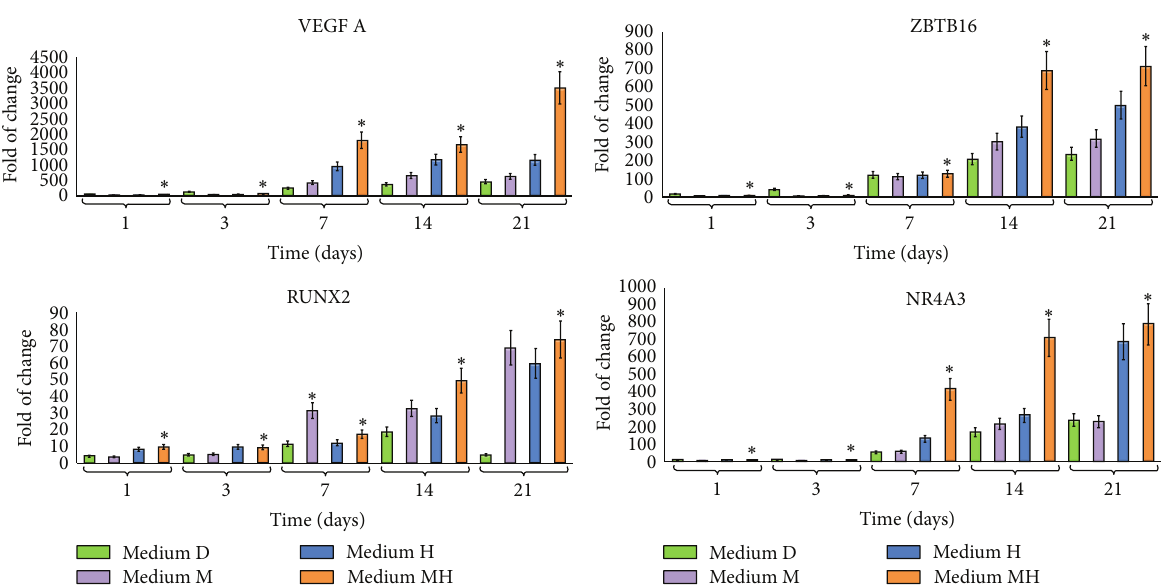
Figure 1: Effect of melatonin and HA + BU + RA exposure on the expression of genes orchestrating hDPSCs commitment toward an osteogenic lineage. Cells were exposed for 1, 3, 7, 14, or 21 days in the presence of one of the 4 conditioned media described under Materials and Methods and based on 100 nM dexamethasone with 200 𝜇 M L-Ascorbic acid 2-phosphate (medium D), 0,01M melatonin (medium M), or a mixture of HA 2 mg/mL + BU 5 mM + RA 1 𝜇 M (medium H) or on a combination of melatonin together with HA + BU + RA (medium MH) or kept at the undifferentiated state by growing on medium C. The amounts of vascular endothelial growth factor A (VEGF A), Runx2, ZBTB16, and NR4A3 mRNA from treated or untreated cells were normalized to GAPDH, and the mRNA expression of cells differentiated with the 4 different conditioned media (D, M, H, and MH) was plotted at each time point as fold change relative to the expression in control undifferentiated cells defined as 1 (mean ± SE; 𝑛 = 6 ). All data from medium D-treated cells, M-treated cells, medium H-treated cells, and medium MH-treated cells at each time point were significantly different from those in control undifferentiated cells. mRNA levels from cells that had been exposed to medium D, medium M, medium H, and medium MH were significantly different from each other at each time point. ∗ Significantly different from medium D-treated cells. Medium D: green bars, medium M: purple bars, medium H: blue bars, and medium MH: orange